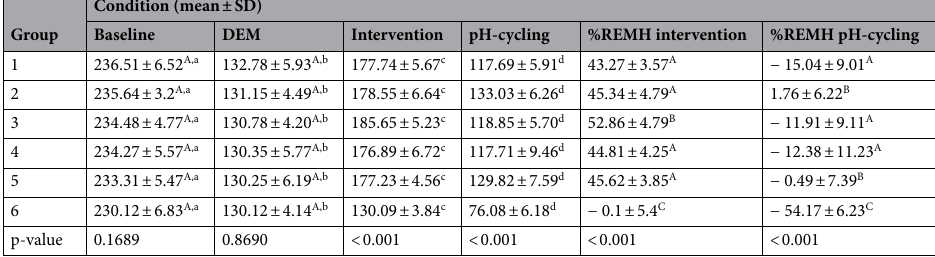
Table 2. Comparison of enamel surface microhardness in experimental groups. %REMH Percentage of enamel microhardness (EMH) recovery, %REMH pH-cycling Percentage of EMH recovery after pH-cycling (n = 12), SD Standard deviation. In each row, means with the same lowercase letter are not significantly different (within-group analysis). In each column, means with the same capital letter are not significantly different (between-group analysis). Statistical significance: p < 0.05. Group 1: Phosphoric acid + Clinpro™; group 2: Phosphoric acid + Aegis®; group 3: Icon®; group 4: Hydrochloric acid + Clinpro™; group 5: Hydrochloric acid + Aegis®; group 6: